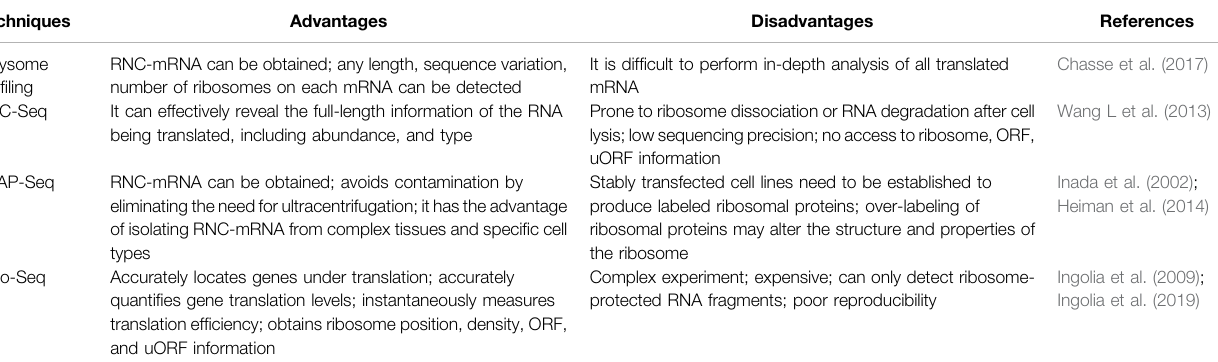
TABLE 1 | Advantages and disadvantages of translation-nomics related